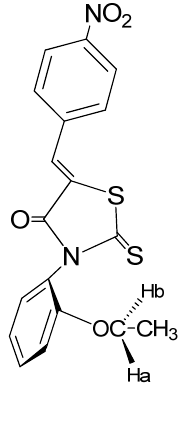
Figure 4. Structure of ( Z )-5-(4-nitrobenzylidene)-3- N -(2-ethoxyphenyl)-2-thioxothiazolidin- 4-one ( 2g